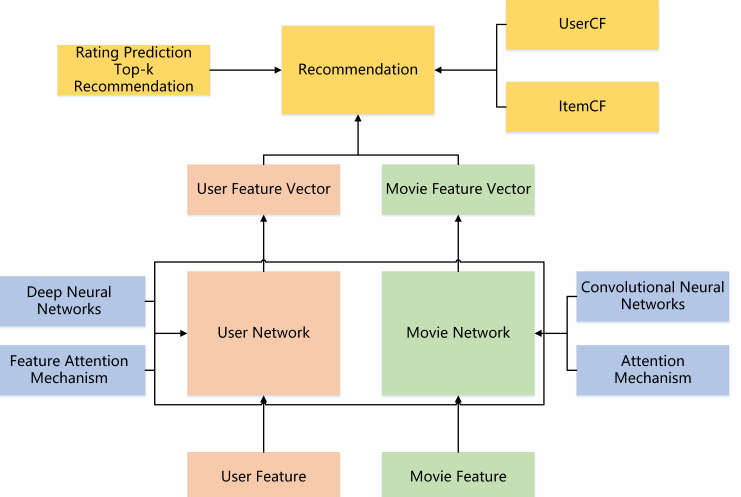
Figure 1. General algorithm design structure diagram. User and movie features are passed through the user and movie networks to generate user and movie feature vectors, respectively, and then the recommendation strategy is